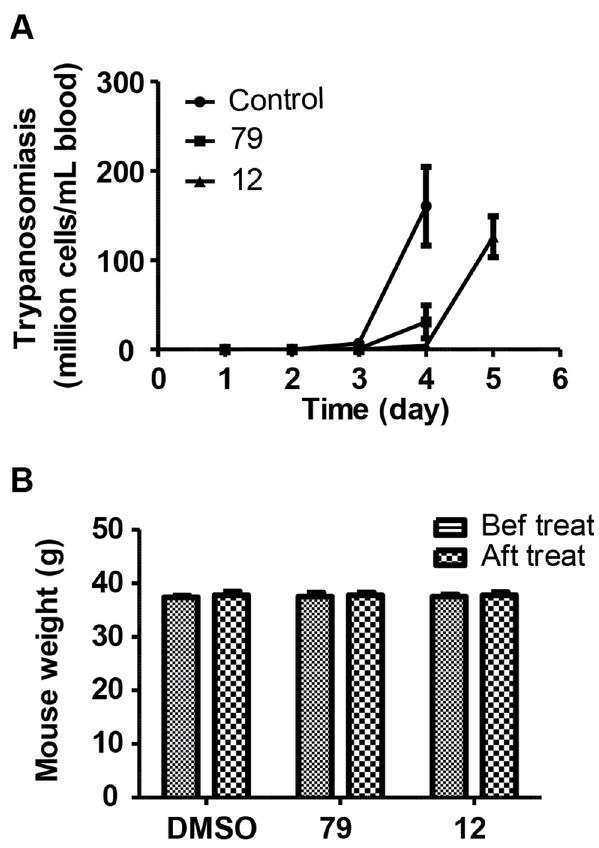
Fig 4. In vivo testing of selective tubulin inhibitors. Mice were randomly divided to three groups (4 mice per group) and infected with 100,000 T . brucei cells per mouse via intraperitoneal injection. Subsequently, mice were treated daily via oral gavage with individual compounds (compound 79 at a dose of 400 mg/kg and compound 12 at a dose of 200 mg/kg) using the sesame oil formulation. The control group received sesame oil and vehicle DMSO. (A) T . brucei cell count of mouse tail blood after mice were treated with our compounds. (B) Mouse weight change before and after the